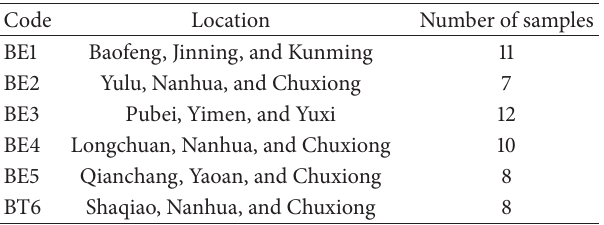
Table 1: Locations and numbers of Boletus edulis samples collected from central Yunnan in